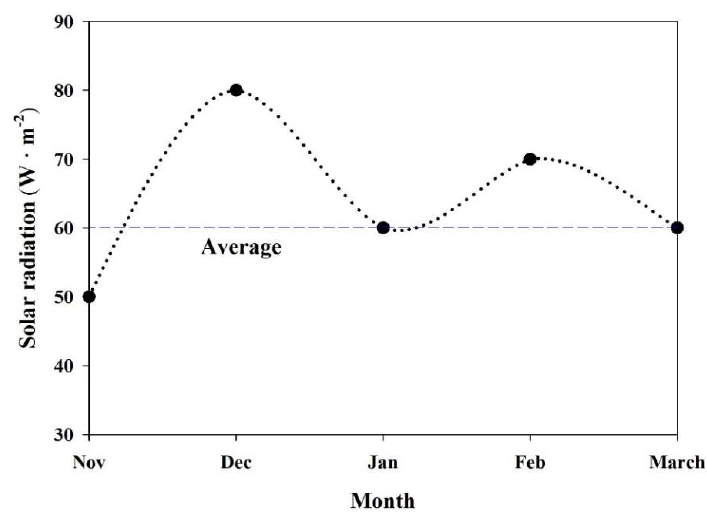
Figure 17. Best monthly solar radiation set point for thermal screen opening.